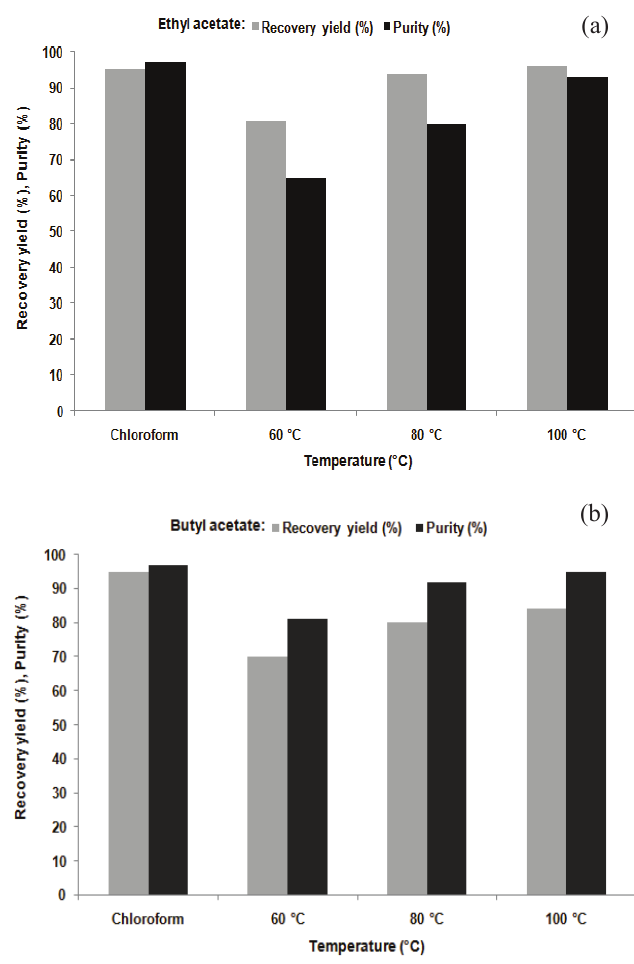
Fig. 2 – Effect of different temperatures on purity and recov- ery yield (%) of PHAs obtained by extraction with a) ethyl ac- etate; b) butyl